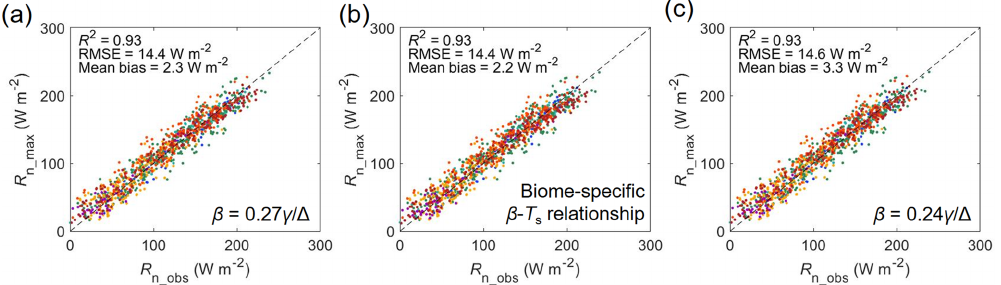
Figure 6. Comparison of the estimated and observed net radiation over saturated land surfaces using three different β – T s relationships. Comparison of estimated net radiation ( R n_max ) with flux site observations ( R n_obs ). (a) Generic land β – T s relationship ( β = 0 . 27 γ/(cid:49) , n = 1128). (b) Biome-specific β – T s relationships (per Fig. 2). (c) Ocean surface β – T s relationship ( β = 0 . 24 γ/(cid:49) , Yang and Roderick, 2019). The colors indicate different biome types (as provided in Fig. 1). The dashed black line indicates the 1 : 1